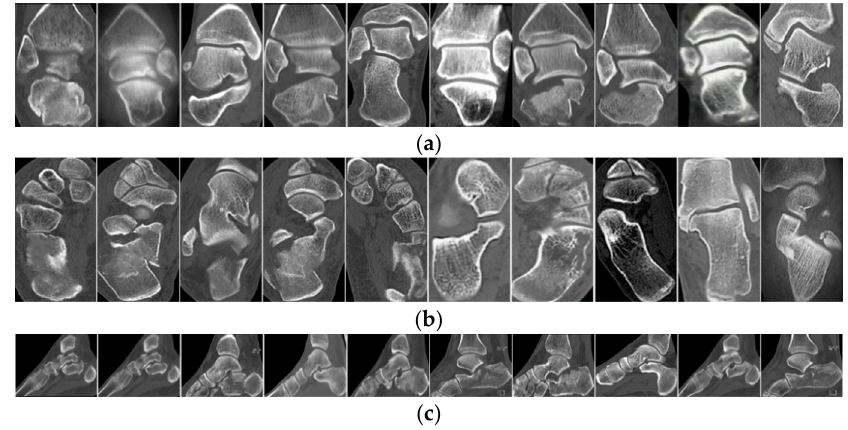
Figure 5. Example images of the tarsal bone: ( a ) Coronal; ( b ) Transverse; and ( c ) Sagittal.